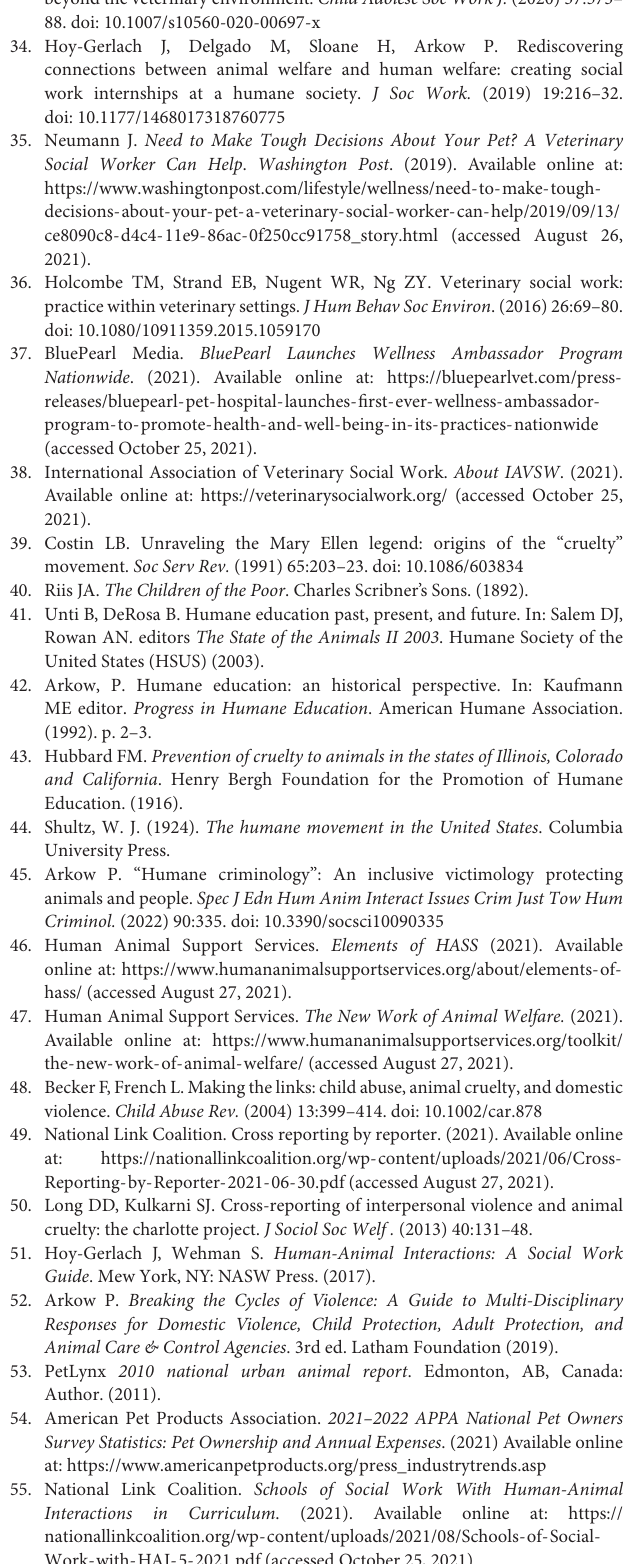
for Clinicians, resEarchers, and Educators. Derwood, MD: The Sidran Press (1995). p.